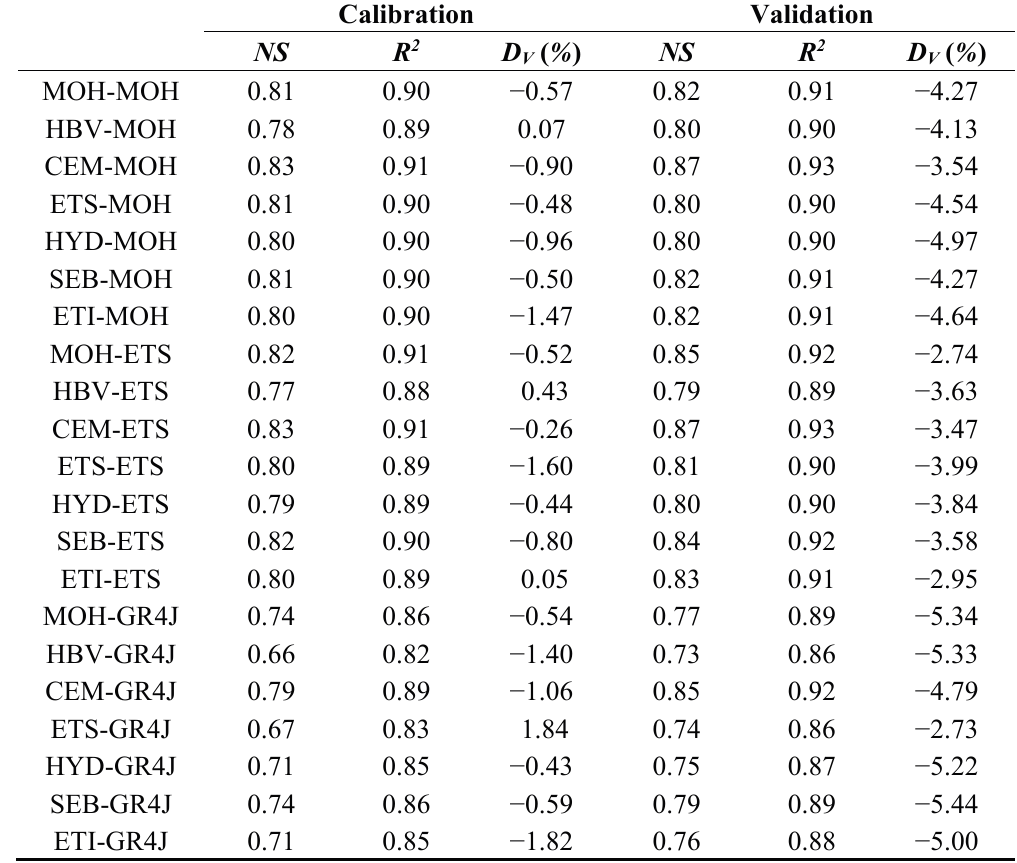
( R 2 ) and the percent deviation of streamflow